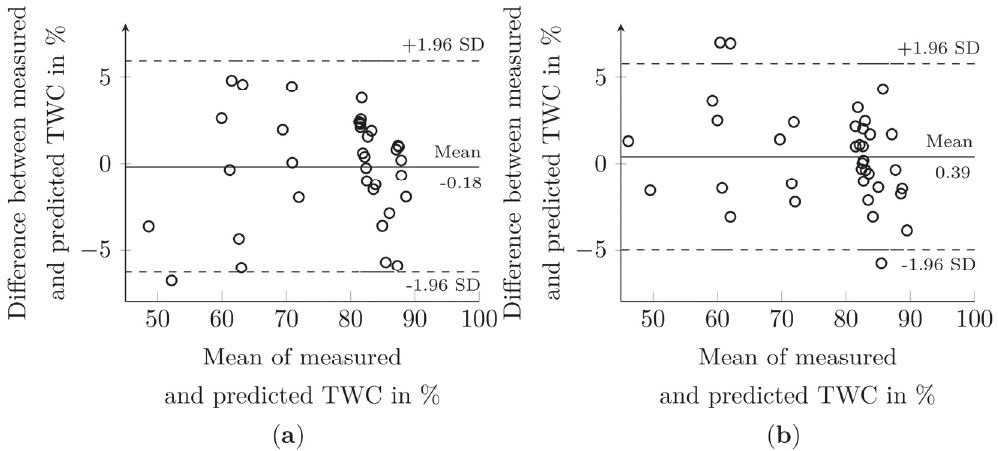
Figure 7. The Bland–Altman plot for ( a ) absorbance and ( b ) reflectance.